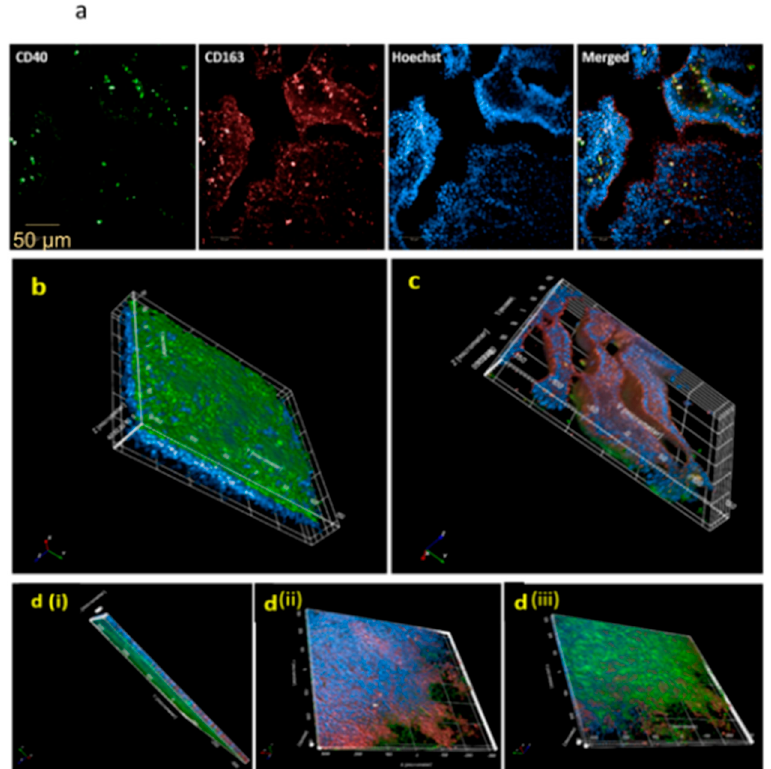
Figure 3. ( a ) CD163 expression 3D viewing within the 3D lung model. Within the 3D lung model treated with dexamethasone (100 µ g mL − 1 ), macrophages expressed both CD40 (Alexa Fluor ® 488, green) and CD163 (Alexa Fluor ® 647, red), indicating the establishment of an immunosuppressed microenvironment. Scale bar_ 50 µ m. The experiment was repeated three times independently. ( b – d ) Macrophage chemotactic migration of M1 macrophages (CD40 + ) is mediated within the 3D microenvironment, while CD163 + macrophages remain on the apical side. Following 24-h stimulation using GM-CSF as a chemoattractant, ( b ) GM-MDMs (CD40 + green) migrate to the bottom of the membrane (basolateral distribution), whereas ( c ) Dexamethasone-induced-MDMs (CD163 + red) stay localized at the top of the membrane (apically lodged). d ( i , ii ) Imaging at different angles, X is the lateral axis and Y depicts direction. At least three independent experiments were performed, and at least three different areas of the membrane were imaged. 20XW Objective, N.A. 1.0. Hoechst 33,342 was applied to label